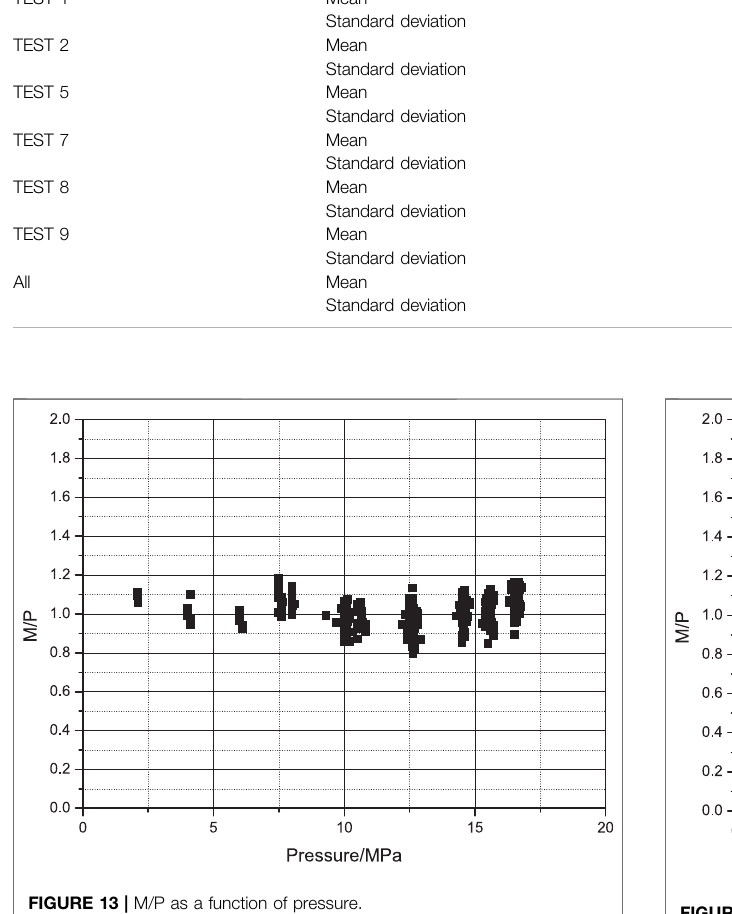
FIGURE 14 | M/P as a function of mass fl ux.